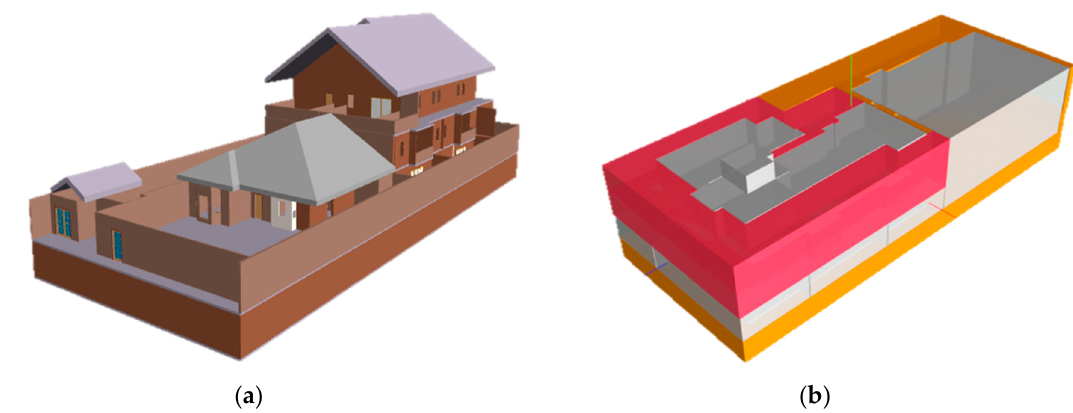
Figure 7. ( a ) A snapshot of the prepared 3D physical model. ( b ) A snapshot of the defined legal model.